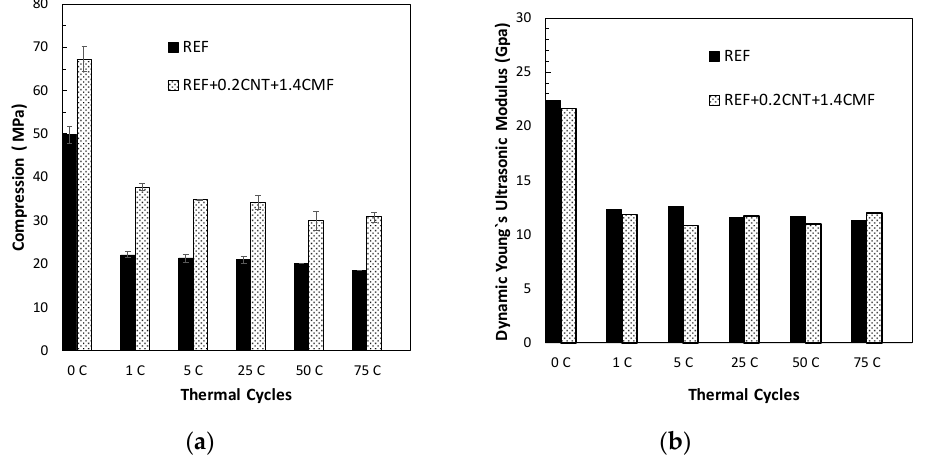
Figure 4. Compressive strength ( a ) and dynamic young modulus ( b ) from SCC with and without CNT+CMF after thermal heat/cool cycles 290 to 550 °C.